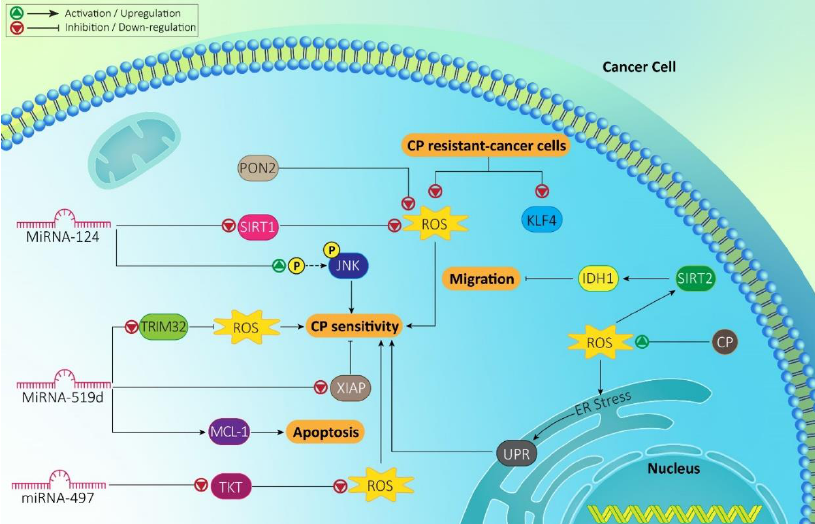
Figure 1. Molecular pathways regulating ROS generation and their role in CP sensitivity. The interesting point is the overgeneration and inhibition of ROS levels in CP sensitivity. ROS can affect migration and proliferation of cancer cells in CP sensitivity. MiRNAs can also function as upstream mediators of ROS in CP sensitivity.